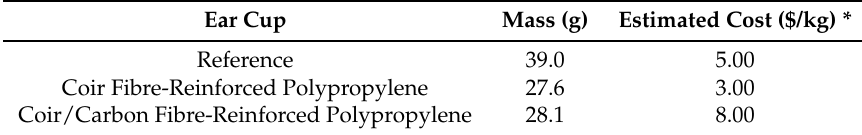
Table 1. Mass and estimated cost of the respective ear cups.